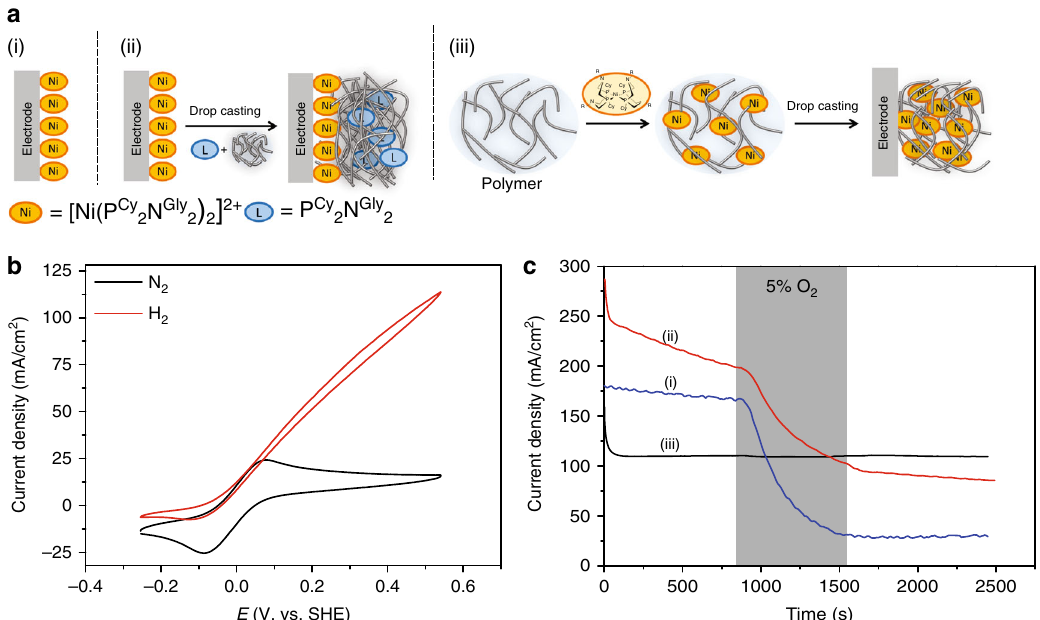
Fig. 2 Catalytic properties and tolerance of CyGly modi fi ed electrodes towards oxygen. a Electrode preparation schemes: (i) A monolayer of CyGly complex; (ii) a monolayer of CyGly complex coated with the pristine polymer and the P Cy 2 N Gly 2 ligand, and (iii) CyGly/polymer fi lm on glassy carbon electrodes. b Cyclic voltammograms of the polymer/catalyst fi lm (iii) under N 2 (black trace) and under H 2 (red trace). Conditions: 20 mV s − 1 , pH = 3, 0.1 M MES/0.1M HEPES + HClO 4 , 25 °C, 2000rpm. c Chronoamperometry experiments under 90% H 2 /10% N 2 with the addition of 5% O 2 (90% H 2 , 5% N 2 ) over 600 s (shaded area) for all three electrode preparations. Conditions: + 541 mV vs. SHE, 25 °C, 2000rpm, pH = 3, 0.1 M MES/0.1M HEPES + HClO 4 . The initial current drop corresponds to slow equilibration processes inside the polymer (establishment of H 2 and Ni 2 +